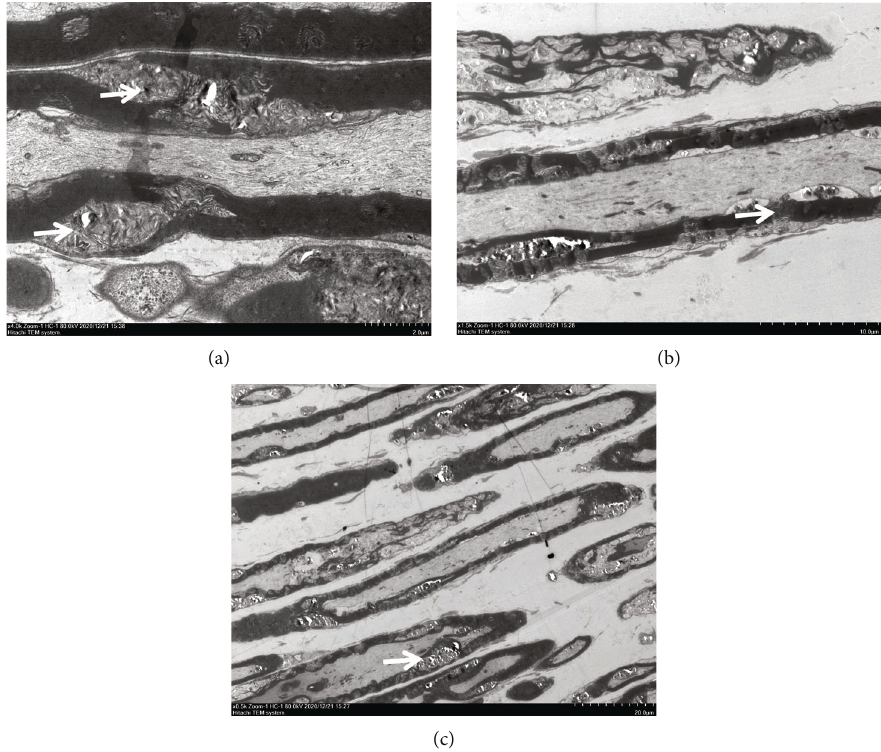
Figure 2: Nerve damage before treatment (the white arrow). Myelin sheath damage was observed at di ff erent magni fi cations, and this change was more obvious at higher magni fi cations (scale is in the lower right